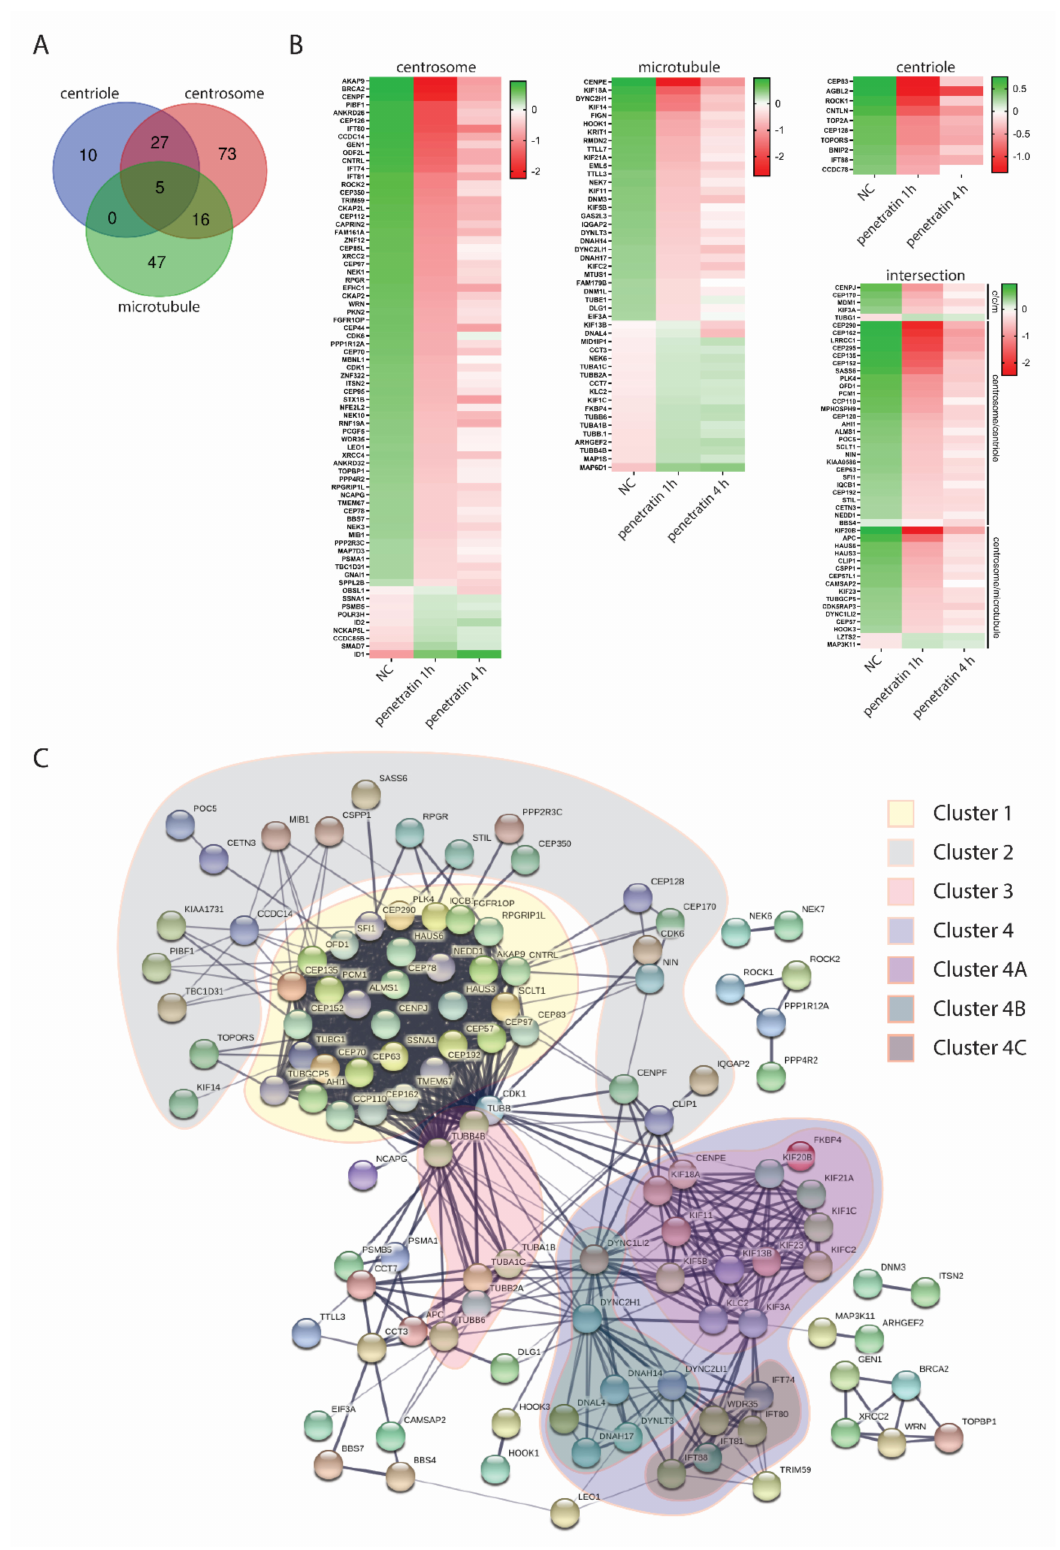
Figure 7. ( A ) Venn diagram of all di ff erentially expressed genes related to gene ontology terms “Centriole”, “Centrosome” and “Microtubule”. ( B ) Heatmap of di ff erentially expressed genes found in ( A ). Genes are organized in descending order based on the averaged log2(normalized read counts) for each sample. ( C ) Clustered interaction map of di ff erentially expressed genes related to microtubules, centrosomes and